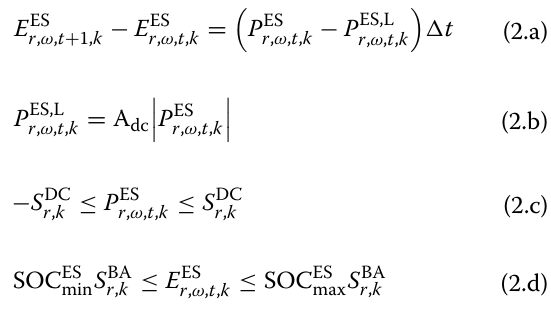
Fig. 1 Structure of ESOP with multi-terminal